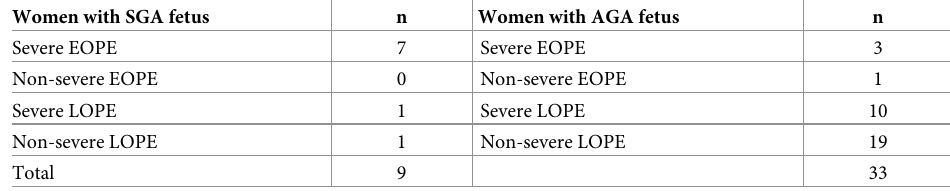
Table 4. Distribution of pre-eclampsia